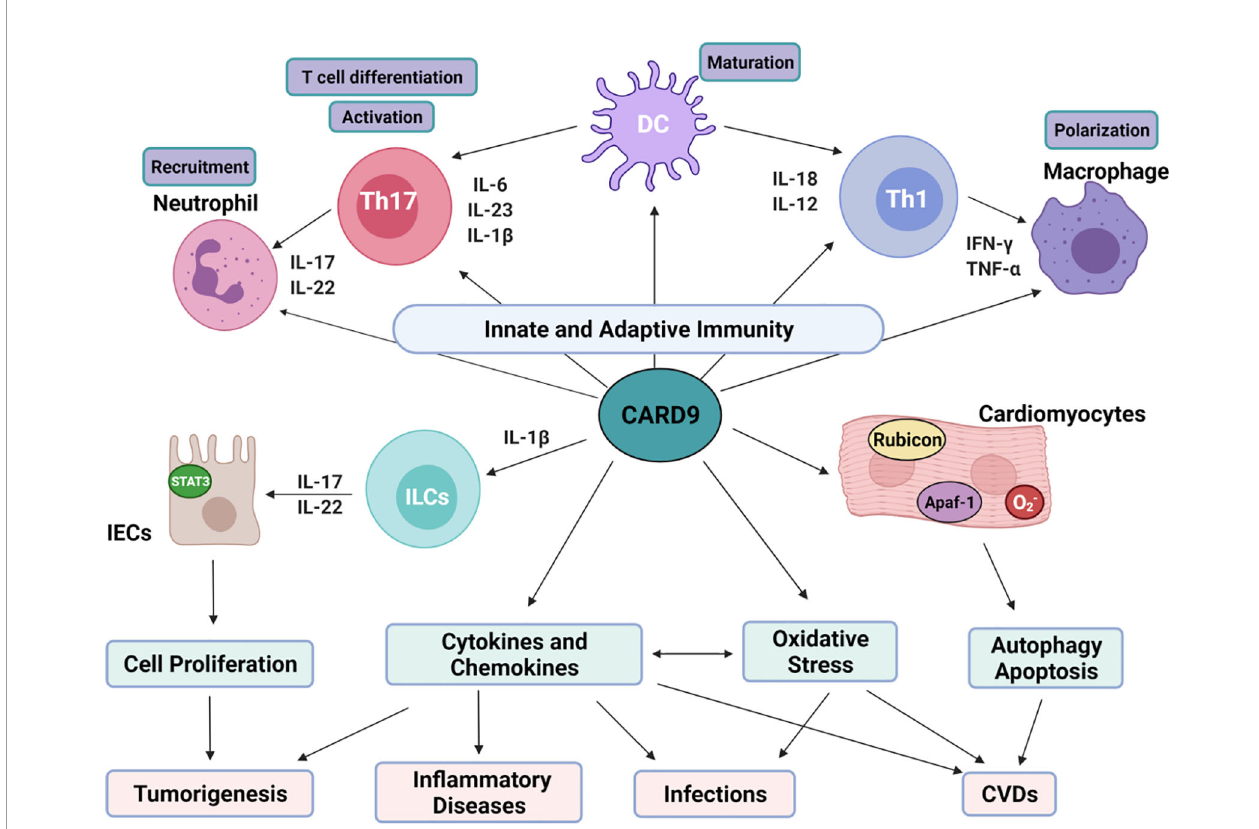
FIGURE 3 | Overview on the role of CARD9 and relations with various diseases. CARD9-mediated cell proliferation, cytokines/chemokines production, oxidative stress, autophagy and apoptosis is critical for tumorgenesis, infections, in fl ammatory diseases and CVDs. (1). CARD9-mediated cytokines production interacts with innate and adaptive immunity. IL-6, IL-23 and IL-1 b are essential for Th17 cell differentiation. IL-17 and IL-22 produced by Th17 cells trigger neutrophil recruitment. IL-12 and IL-18 from myeloid cells stimulate Th1 cell differentiation. IFN- g released from Th1 then mobilizes and activates macrophages. The activated neutrophils and macrophages can further enhance Th1/Th17 differentiation and anti-fungal mechanisms. (2). CARD9 promotes the growth of IECs through interaction with ILCs. IL-1 b from myeloid cells activates ILCs, leading to the release of IL-17 and IL-22 through CARD9-dependent signaling. After binding to its receptor on IECs, IL-22 activates STAT3, promoting IECs regeneration physiologically and tumor generation pathologically. (3). CARD9 can be activated by oxidative stress directly and indirectly. There ’ s crosstalk between ROS and cytokines prosunction. In cardiomyocytes, CARD9 can bind with Apaf-1 to disassociate apoptosome complex to inhibit apoptosis. CARD9 can also interact with Rubicon to promote autophagolysosome